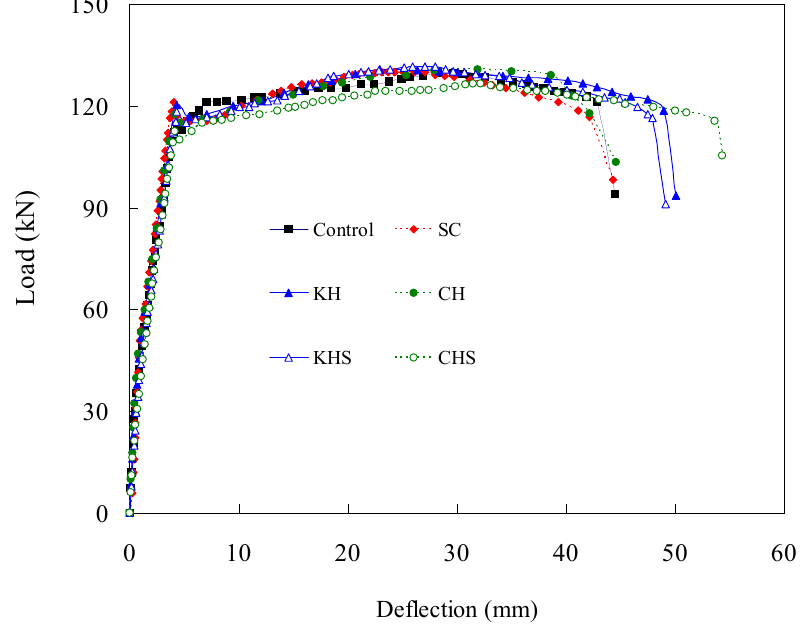
Figure 14. Load-deflection curves for Hwangtoh and slag cement concrete specimens.